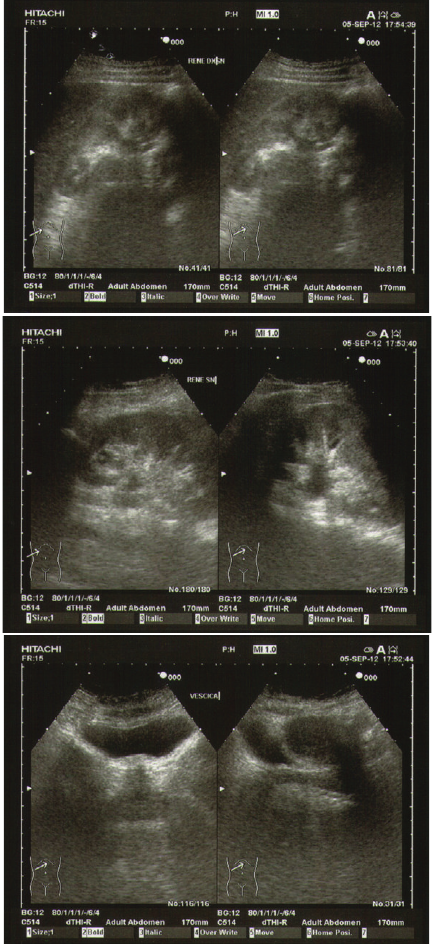
Figure 1: Left kidney of normal size, with increased thickness and parenchymal echogenicity due likely to an inflammatory process, with hydronephrosis of first